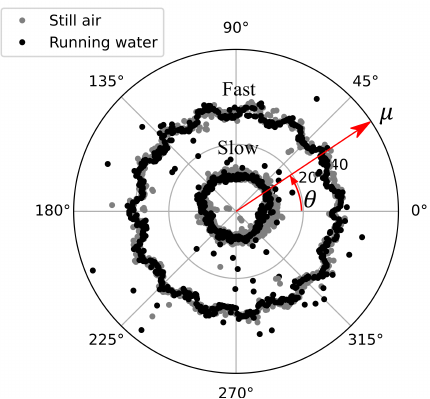
Figure 7. Polar plot showing membrane deformation ( µ ) in still air and in running water for fast actuation (outer rings) and slow actuation (inner rings). The same offset for the fast actuation case is used as in Figure